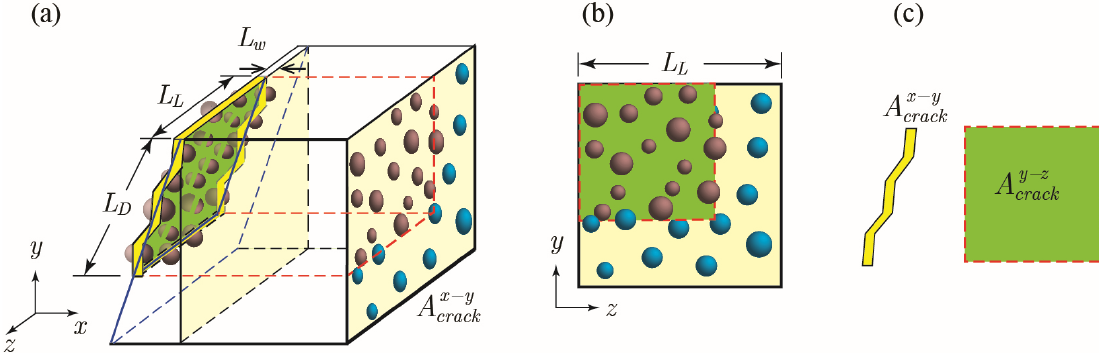
Figure 5. Characteristics of a crack related to the calculation of crack fill ratio. ( a ) View of crack plane; ( b ) View of y – z plane with projection of crack; ( c ) Definition of 𝐴 (cid:3030)(cid:3045)(cid:3028)(cid:3030)(cid:3038)(cid:3051)(cid:2879)(cid:3052) and 𝐴 (cid:3030)(cid:3045)(cid:3028)(cid:3030)(cid:3038)(cid:3052)(cid:2879)(cid:3053) .